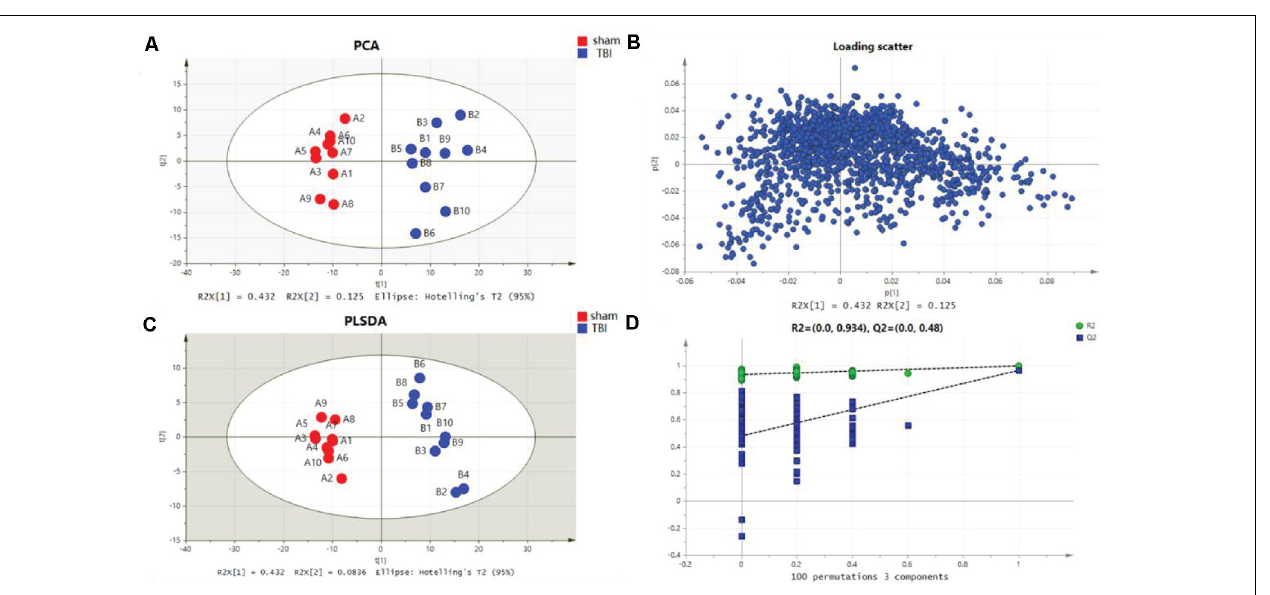
FIGURE 4 | Metabolomic fingerprint analysis for the hippocampus in principal component analysis (PCA) and partial least-square discrimination analysis (PLS-DA). (A) PCA plots in hippocampal traumatic brain injury (TBI) versus sham. (B) Loading plot corresponding to the PCA score scatter plot for hippocampal TBI. (C) PLS-DA results for hippocampal TBI [R2Y (cum) = 0.997 and Q2Y (cum) = 0.964]. (D) Validation plot obtained from 100 permutation tests for the